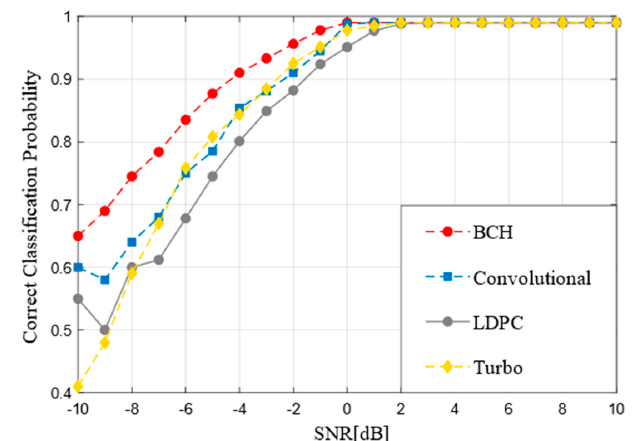
Figure 4. Recognition performance of the improved RNN model for each code type.